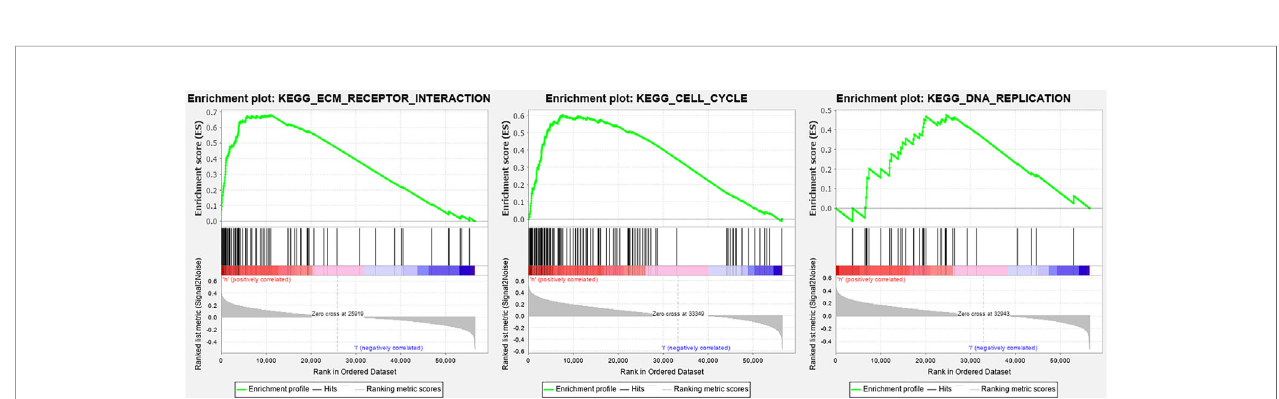
FIGURE 9 | Gene Set Enrichment Analysis of ENO1 in KEGG pathways. The enrichment score increased with the number of enriched genes and vice versa . The plots show the curves of ECM receptor interaction ( P = 0.00), cell cycle ( P = 0.04), and DNA duplication ( P = 0.01).